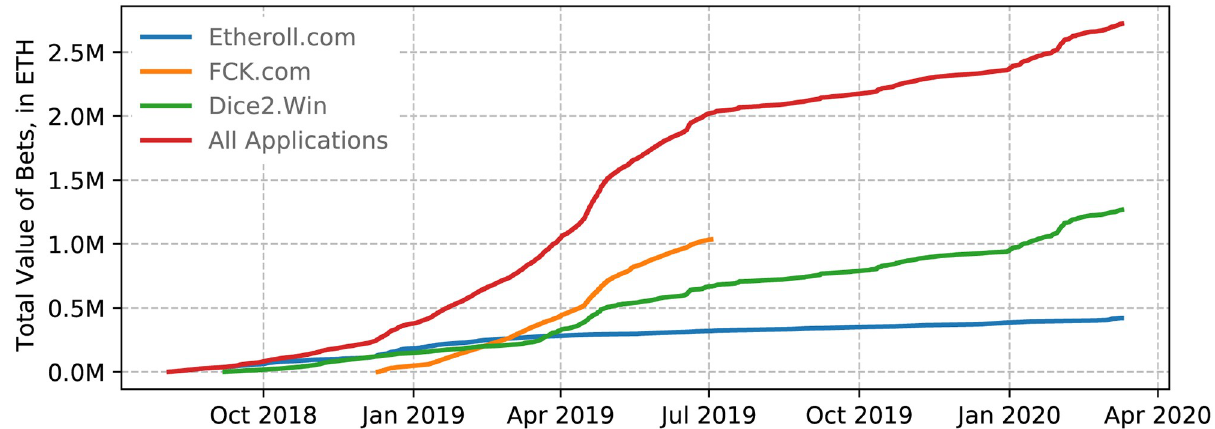
Fig 3. Cumulative value of bets placed through each application individually, and all applications combined over the period studied. The data and code used to create this figure is available at https://osf.io/8bfyj/.